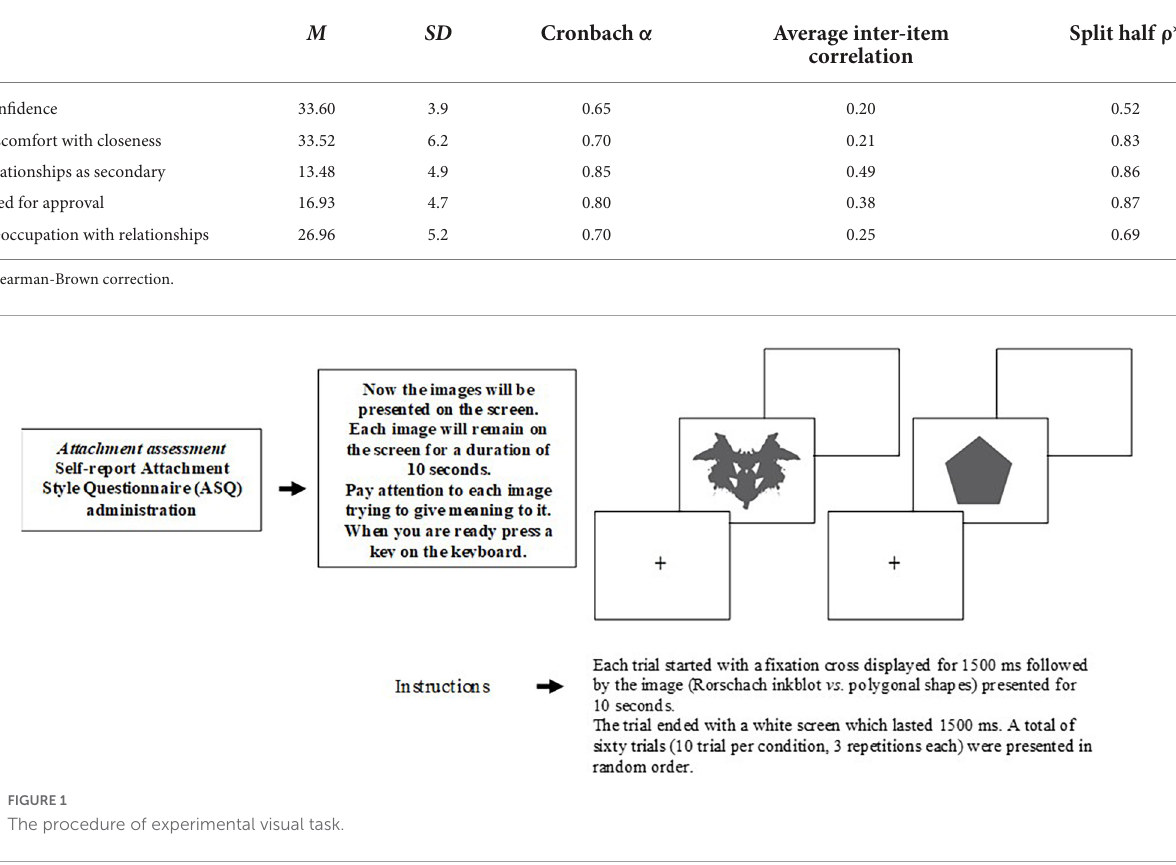
(minus formal quality); movement (human, animal, and inanimate); and embellishment (deviant verbalization, deviant response, peculiar logic, incongruous combination, fabulized combination, contamination, morbid content, cooperative movement, and aggressive